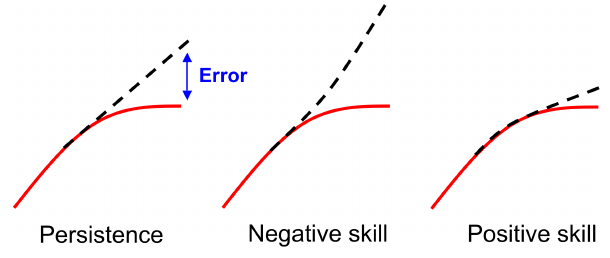
Figure 1. Positive skill in forecasts (black line) requires doing bet- ter than persistence in predicting future evolution of a quantity (red